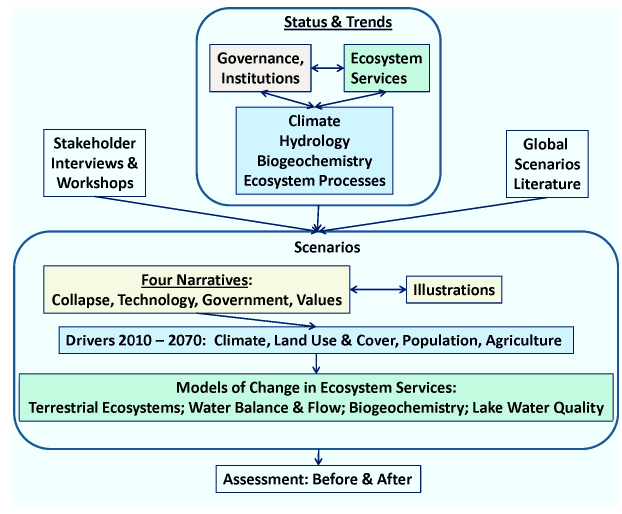
Fig. 1. Major components of the research process used in this